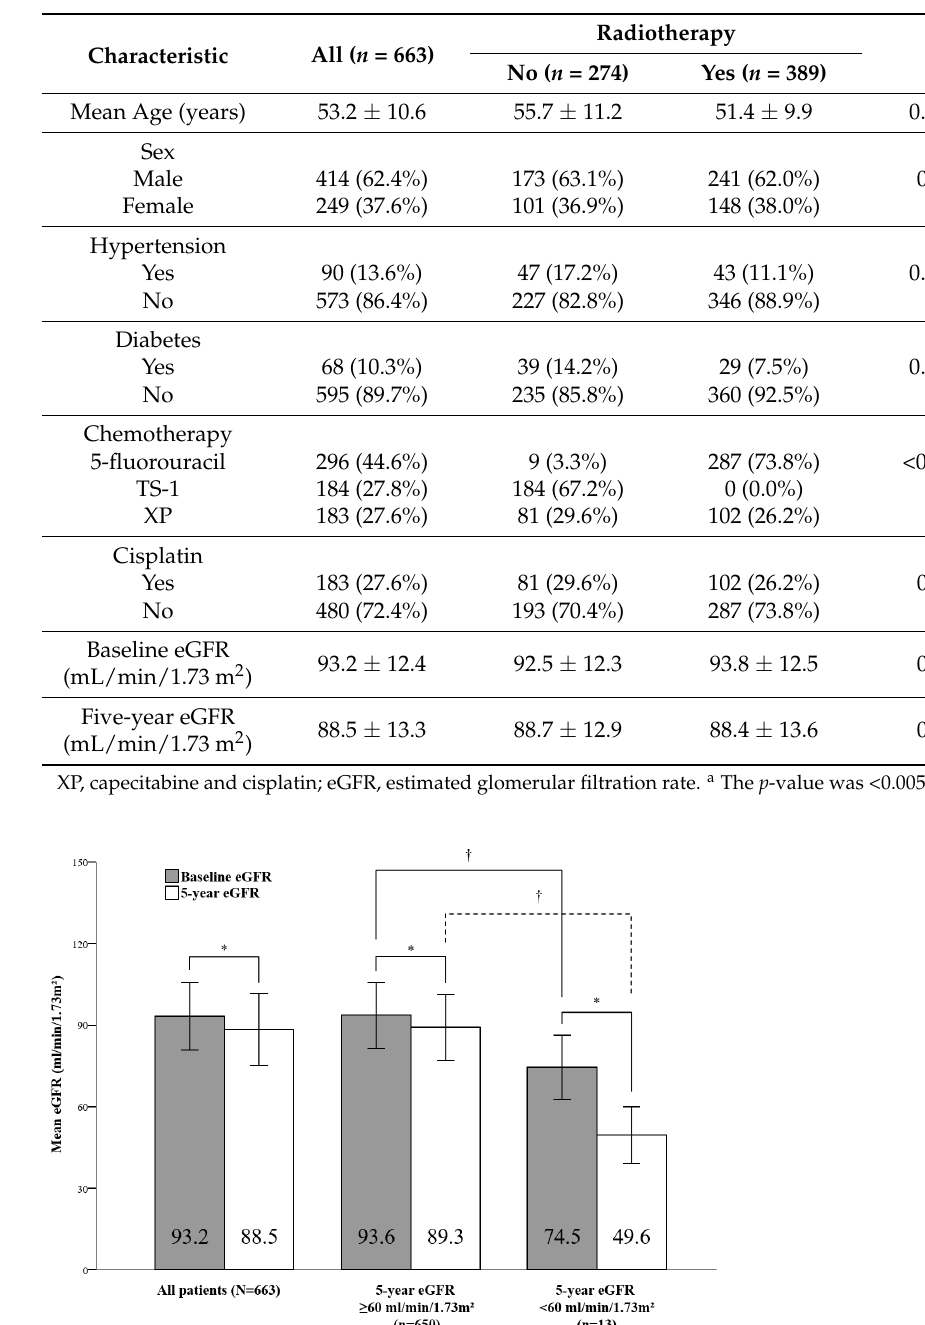
Table 2. Patient characteristics according to radiotherapy.